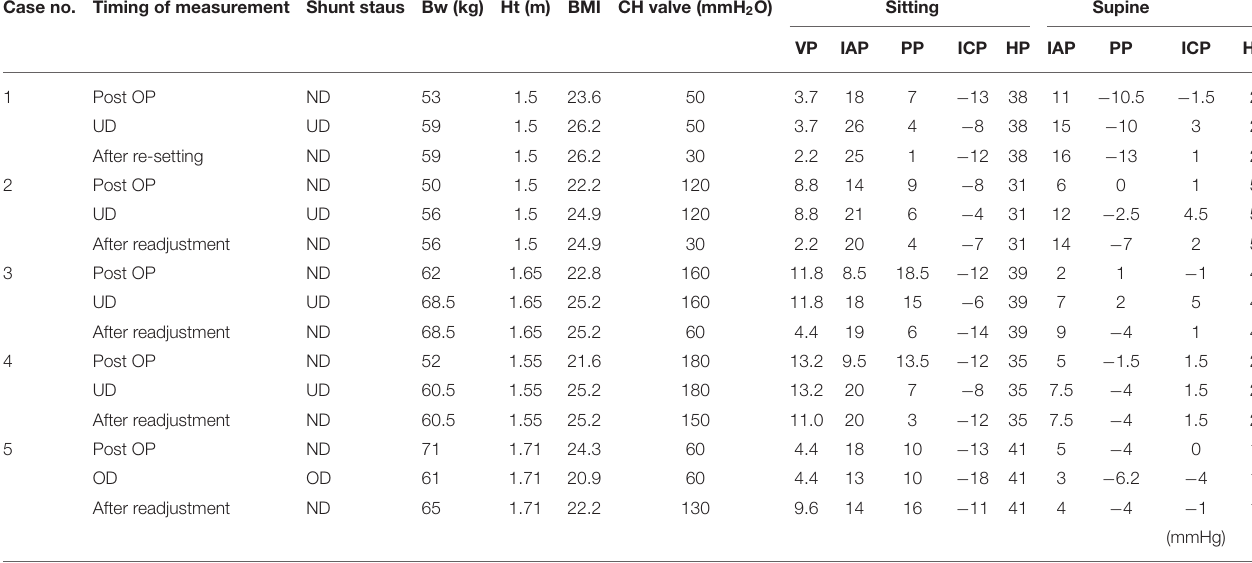
TABLE 3 | Changes in all shunt-related pressures pre-, during, and post-shunt